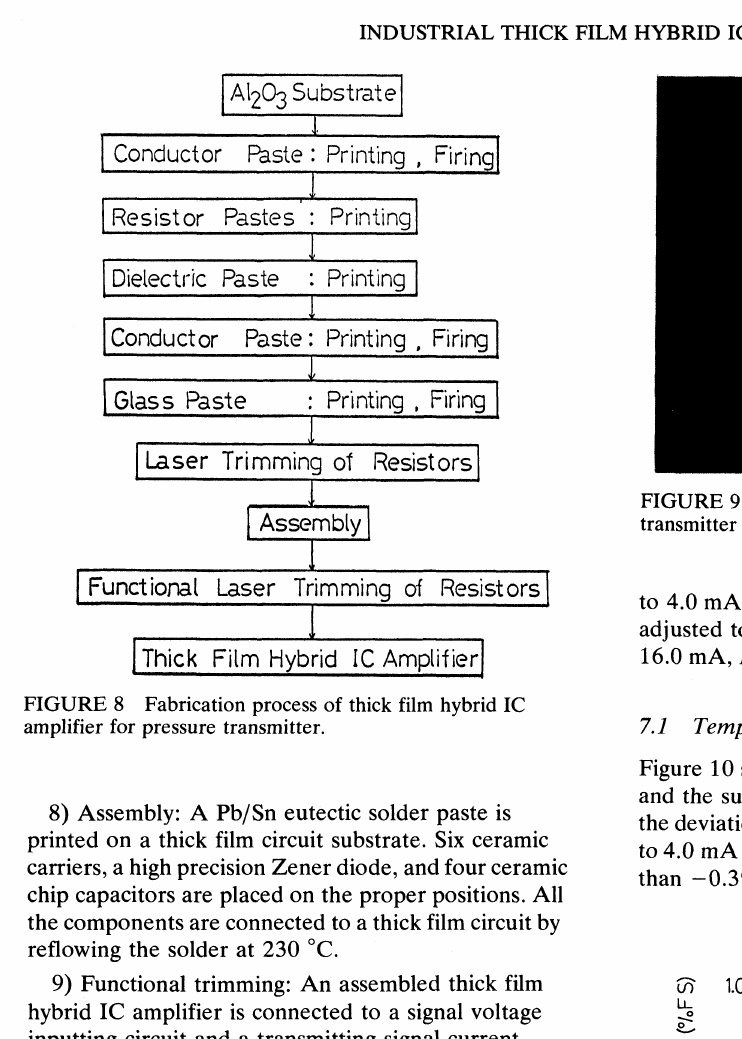
FIGURE 10 Zero point shift vs.